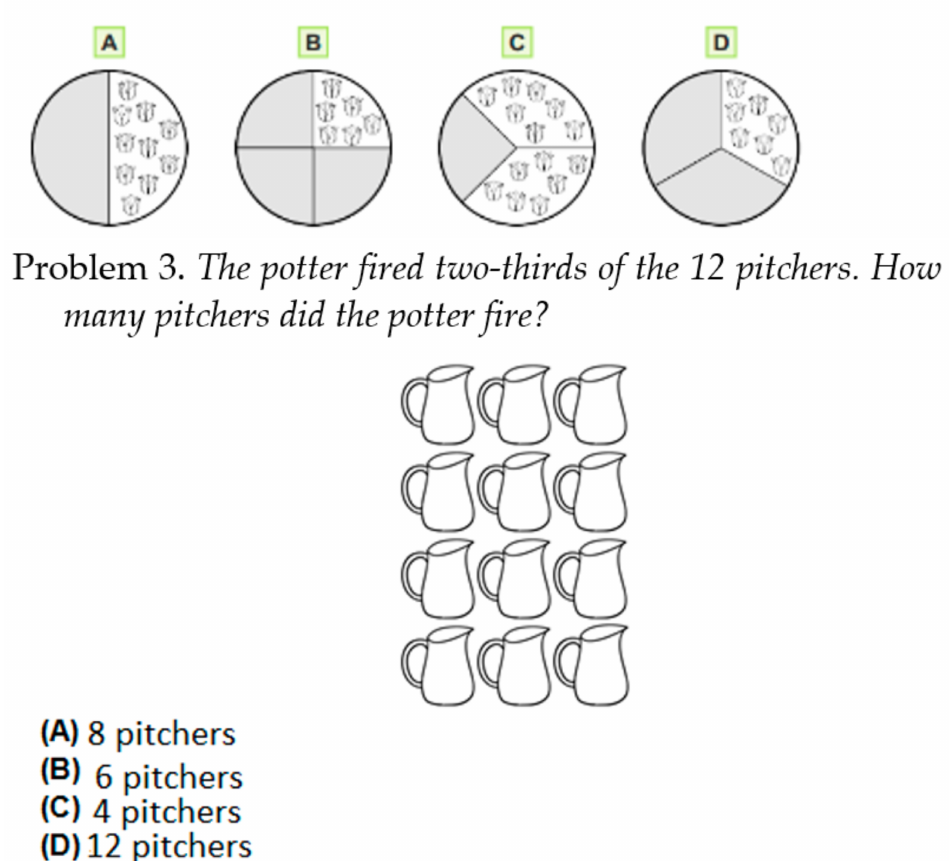
Figure 3. Fraction problems from